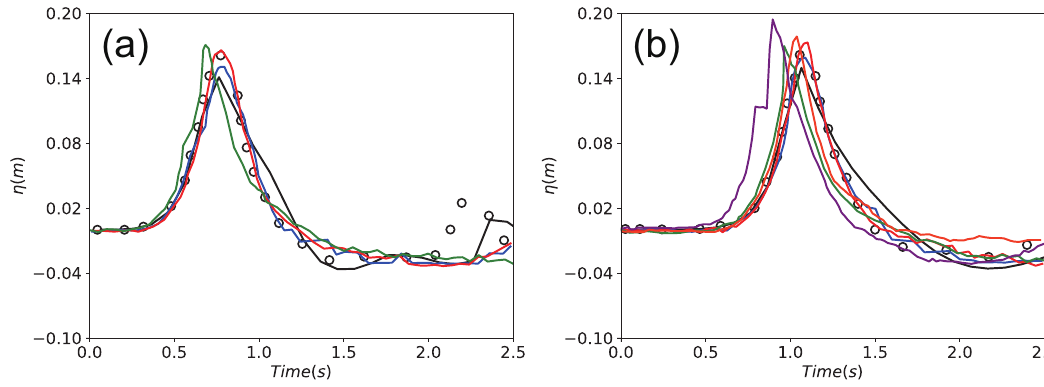
Figure 3. Water surface elevation η varying with time at different positions. ( a ) x = 1.2 m and ( b ) x = 1.8 m correspond to the relative positions x/h = 5.0 and 7.5 in Heller et al. [5]: experimental data (circle), current solution (black), ISPH results (ISPH(a), blue; ISPH(b), red) of Yeylaghi et al. [29], DEM-SPH results (green) [49], and DualSHPysics results (DualSPHysics(a), orange; DualSPHysics(b), purple) of Heller et al. [5]. DualSPHysics(a) results are obtained using a reduced slide front-impact velocity of 1.32 m/s, and DualSPHysics(b) results are obtained using an unreduced slide front-impact velocity of 2.43 m/s; ISPH(a) results are obtained with particle resolution of 0.01 m, and ISPH(b) results are obtained with particle resolution of 0.005 m. The particle resolution in DualSPHysics is 0.01 m.